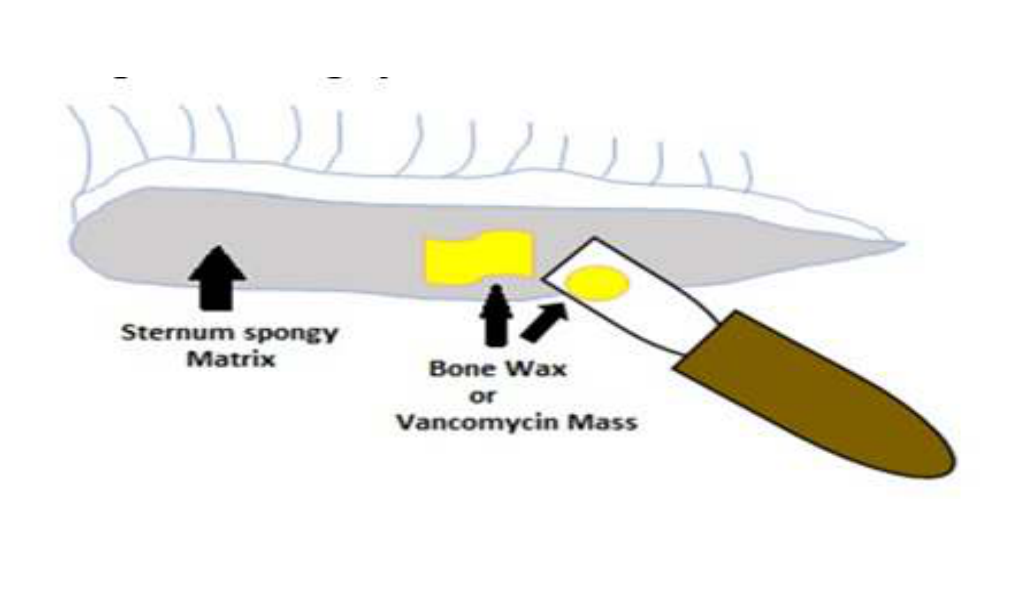
Figure1: Vancomvcin paste and bone wax application technique. From Original Drawing by Machuca Maldonado LA